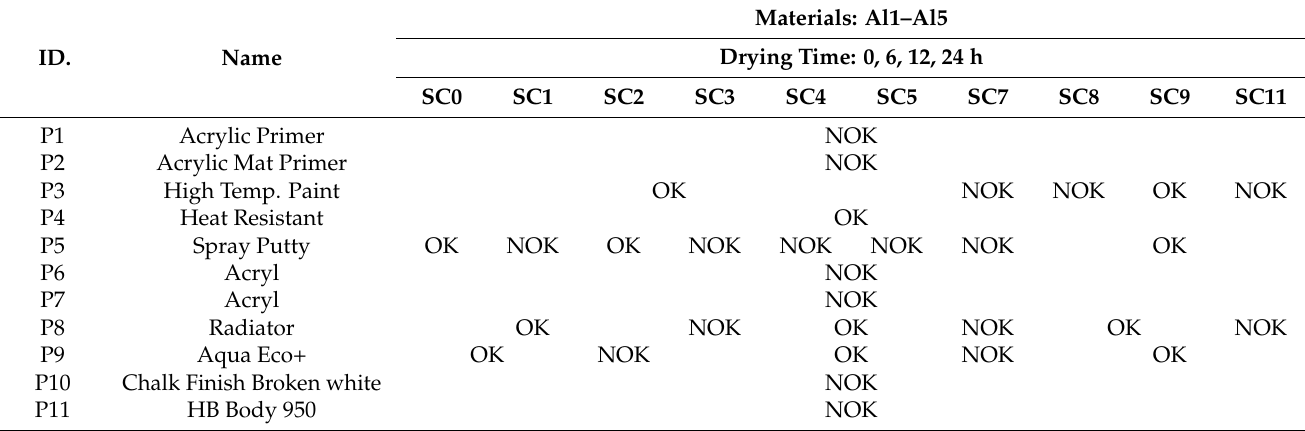
Table 7. Results of the cross-cut